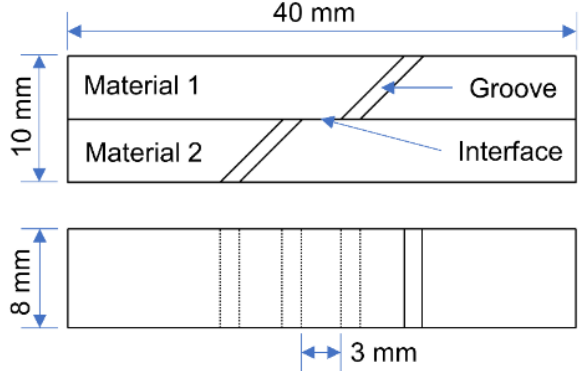
Figure 8. Schematic diagram of shear test specimen.